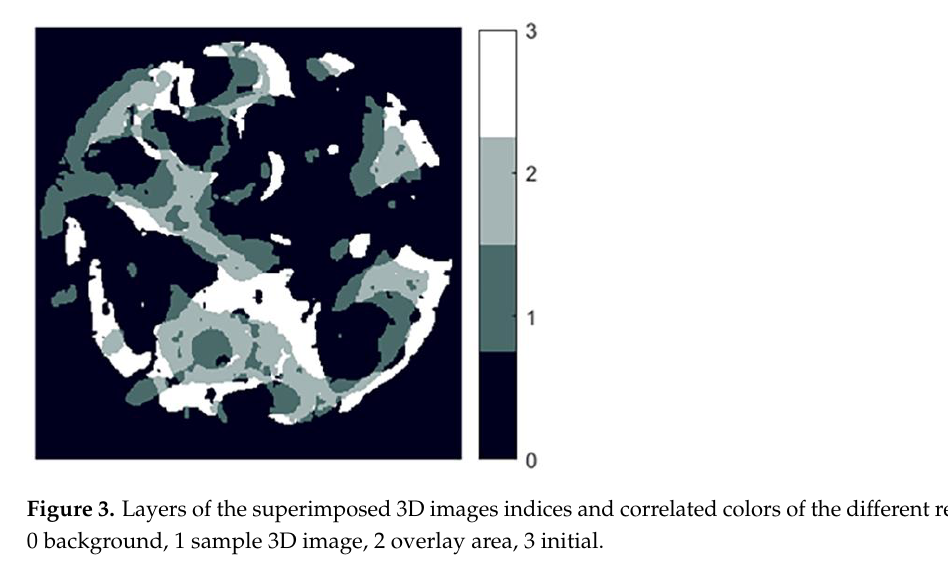
Table 3. Load of failure of one specimen each and the resulting